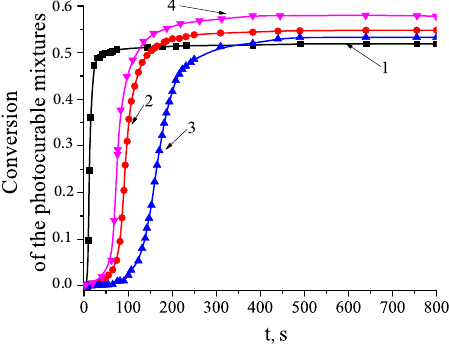
Figure 6. Conversion of: The monomer mixture (1); the nanocomposite with 1.5 wt. % Au1 (2) and 2 wt. % Au1 (3); the nanocomposite with 1.3 wt. % Au2